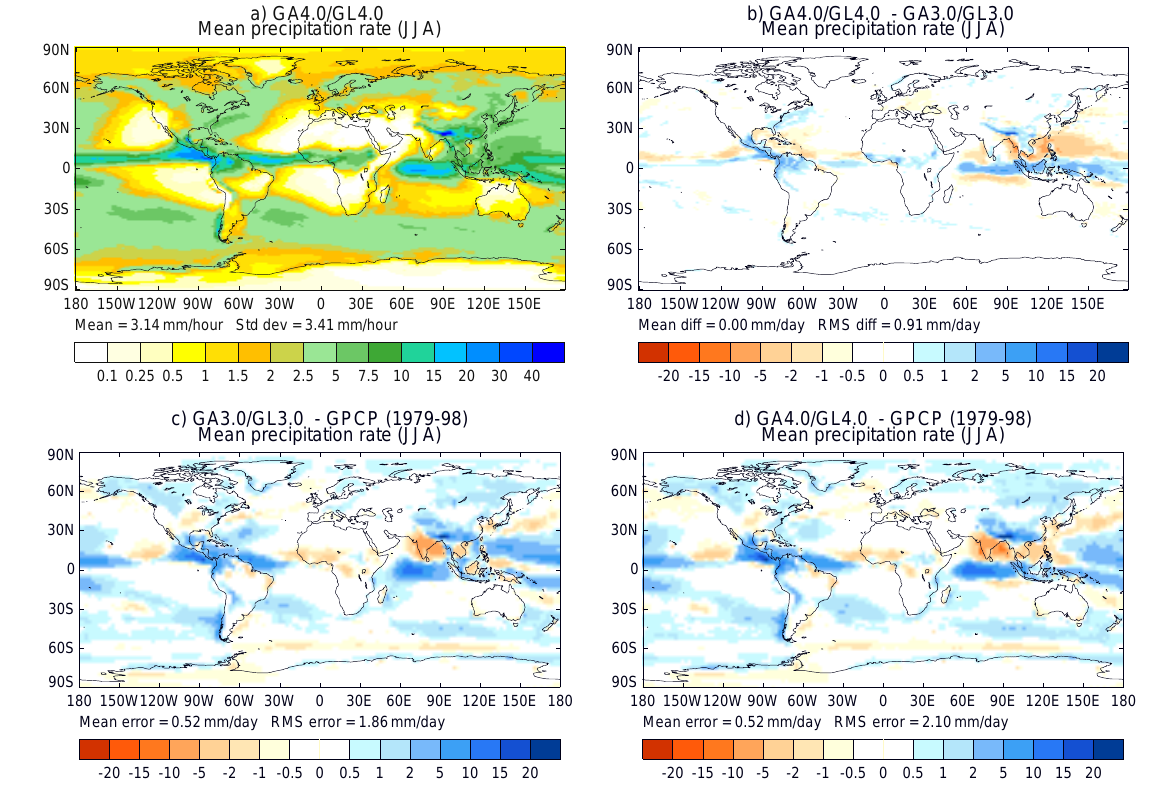
Fig. 9. Climatological mean precipitation rate during JJA from N96-AL_clim using the same format as Fig. 7. frequent mid-level and shallow convective rain. Over the Indian Ocean, however, the more intense convection dom- inates, resulting in a slightly increased wet bias here and slightly larger dry bias over India. Hence, for the monsoon region, the right balance of intensities appears to be critical to avoid one region dominating over